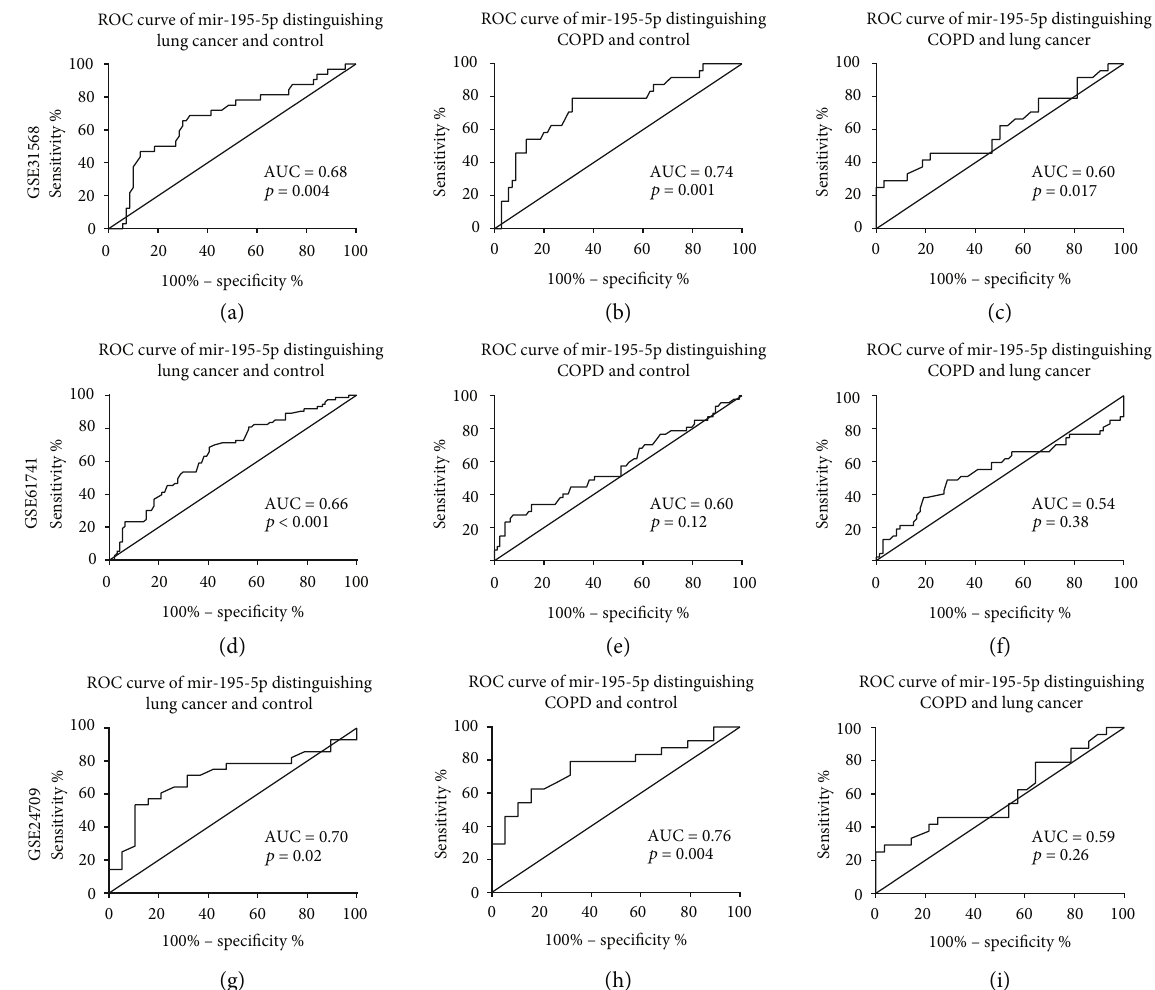
Figure 3: ROC curves of hsa-miR-195-5p to distinguish lung cancer patients, COPD patients, and normal controls. In all three datasets, hsa-miR-195-5p showed good performance in distinguishing between lung cancer or COPD patients and normal controls, but not between lung cancer and COPD